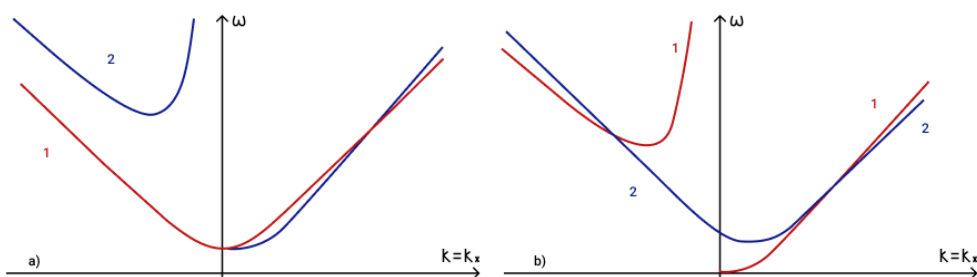
Figure 12. Phase matching condition for ( a ) two magnetogravity waves one magneto-Rossby wave: 1— ω = ω mgr ( k x ) , 2— ω = ω mr 1 ( k x − k x magnetogravity wave: 1 — ω = ω mr 1 ( k x ) , 2— ω = ω mg ( k x − k x